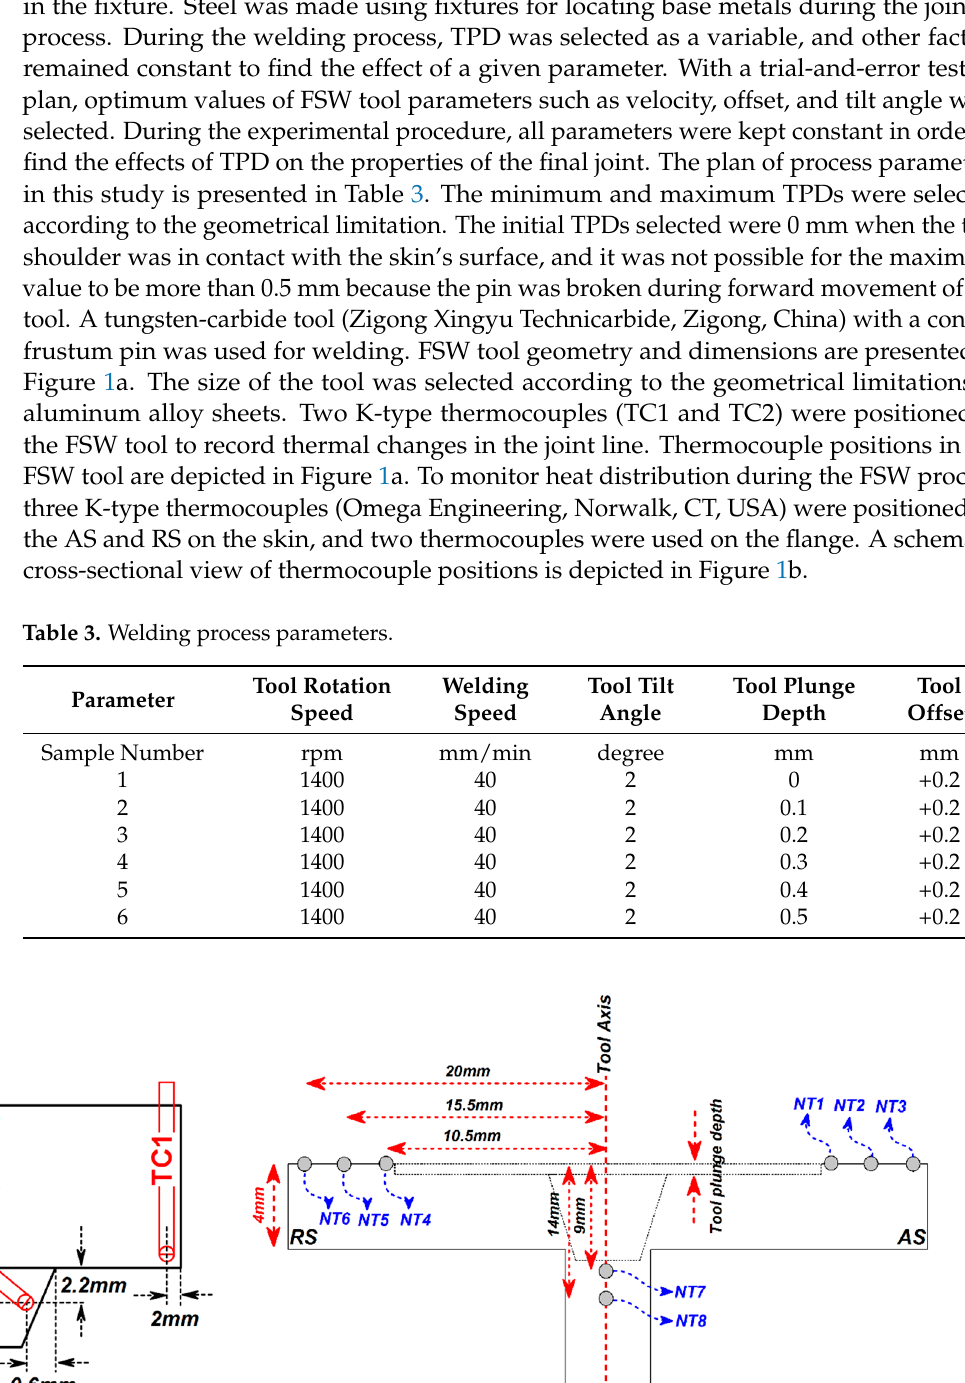
Table 2. AA6068 aluminum alloy chemical composition.